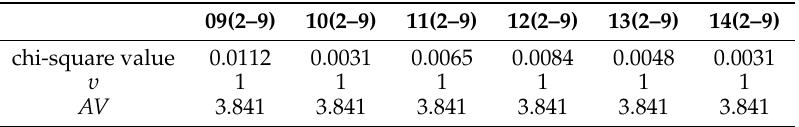
Table A3. Chi-square values and degrees of freedom for the first half of the year (FHY, e.g., 09(2–9) stands for February to September of 2009, and υ denotes degrees of freedom and AV denotes the accepting value at a 5% significant level with degrees of freedom 1).